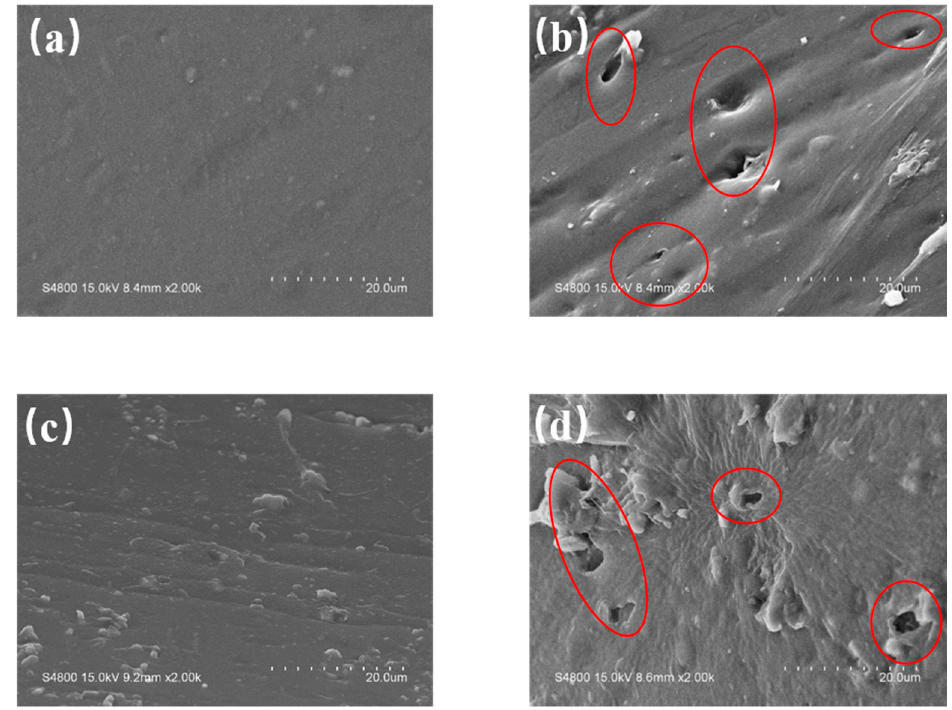
Figure 13. SEM images of surface morphology of the PVC biofilm carrier: ( a ) PVC, ( b ) PVC/mAC-PVA, ( c ) PVC/PVA-5, ( d ) PVC/mAC-PVA-5. The red circle is the hole.